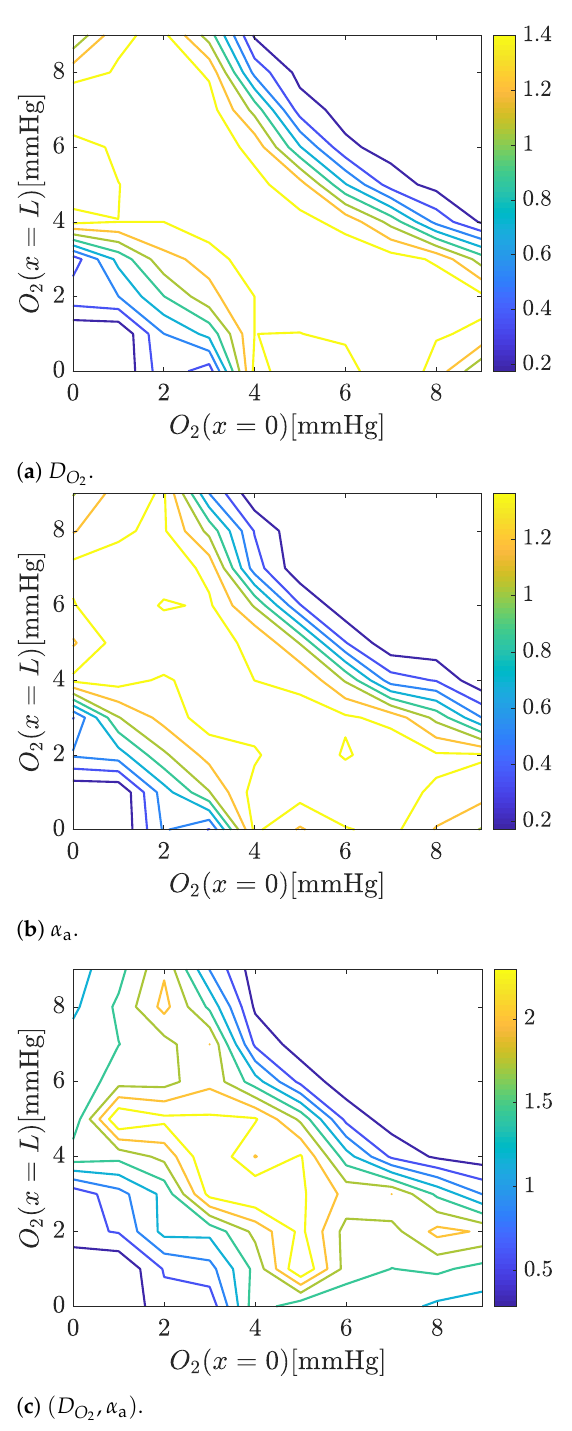
Figure 9. Iso-utility curves for parameters related to oxygen for an initial concentration of C 0 = 5 × 10 7